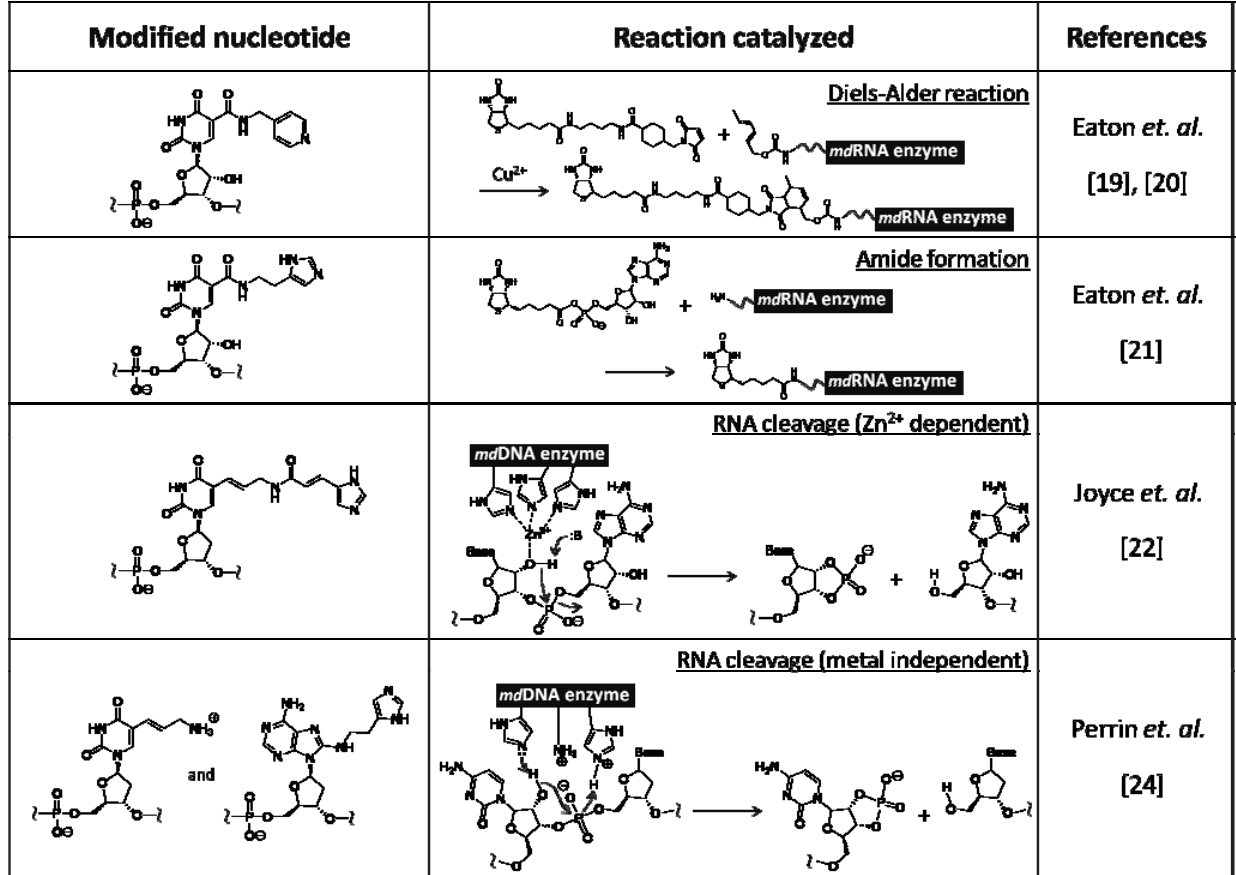
Table 1. Examples of chemically modified RNA/DNA